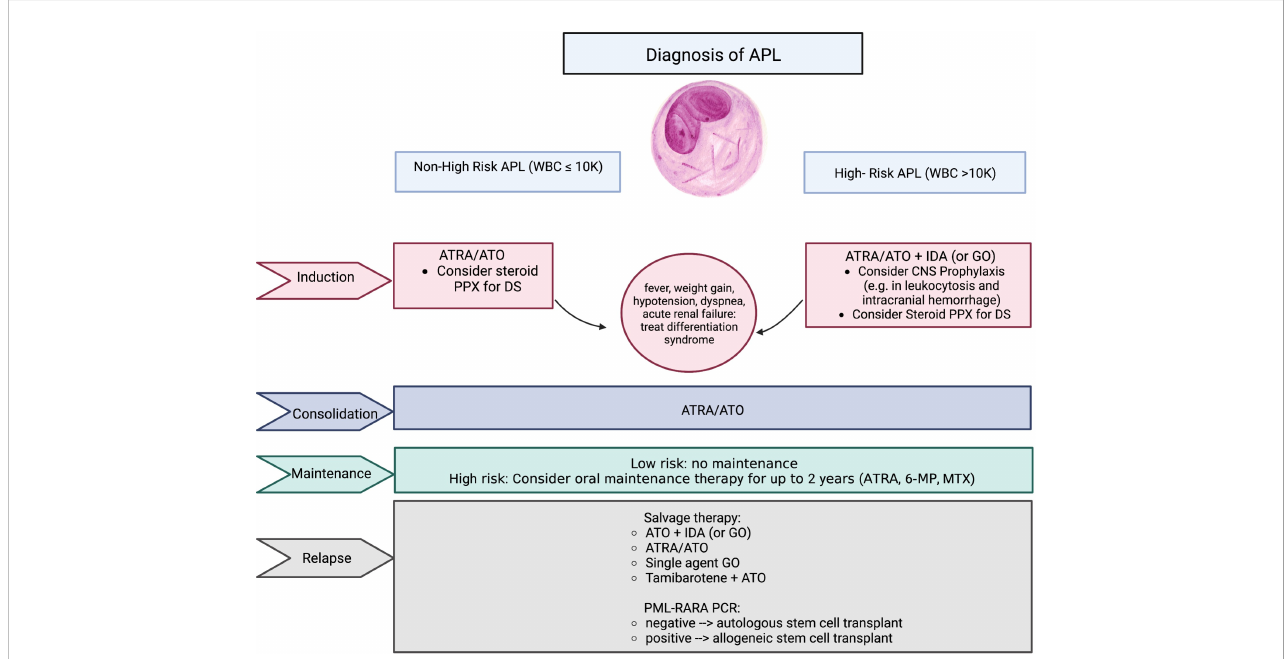
FIGURE 1 Summary of key agents used in the treatment of APL. APL, acute promyelocytic leukemia; WBC, white blood cell count; ATRA, all-trans retinoic acid; ATO, arsenic trioxide; GO, gemtuzumab ozogamicin; PPX, prophylaxis; DS, differentiation syndrome; 6-MP, 6-mercaptopurine; MTX, methotrexate; PCR, polymerase chain